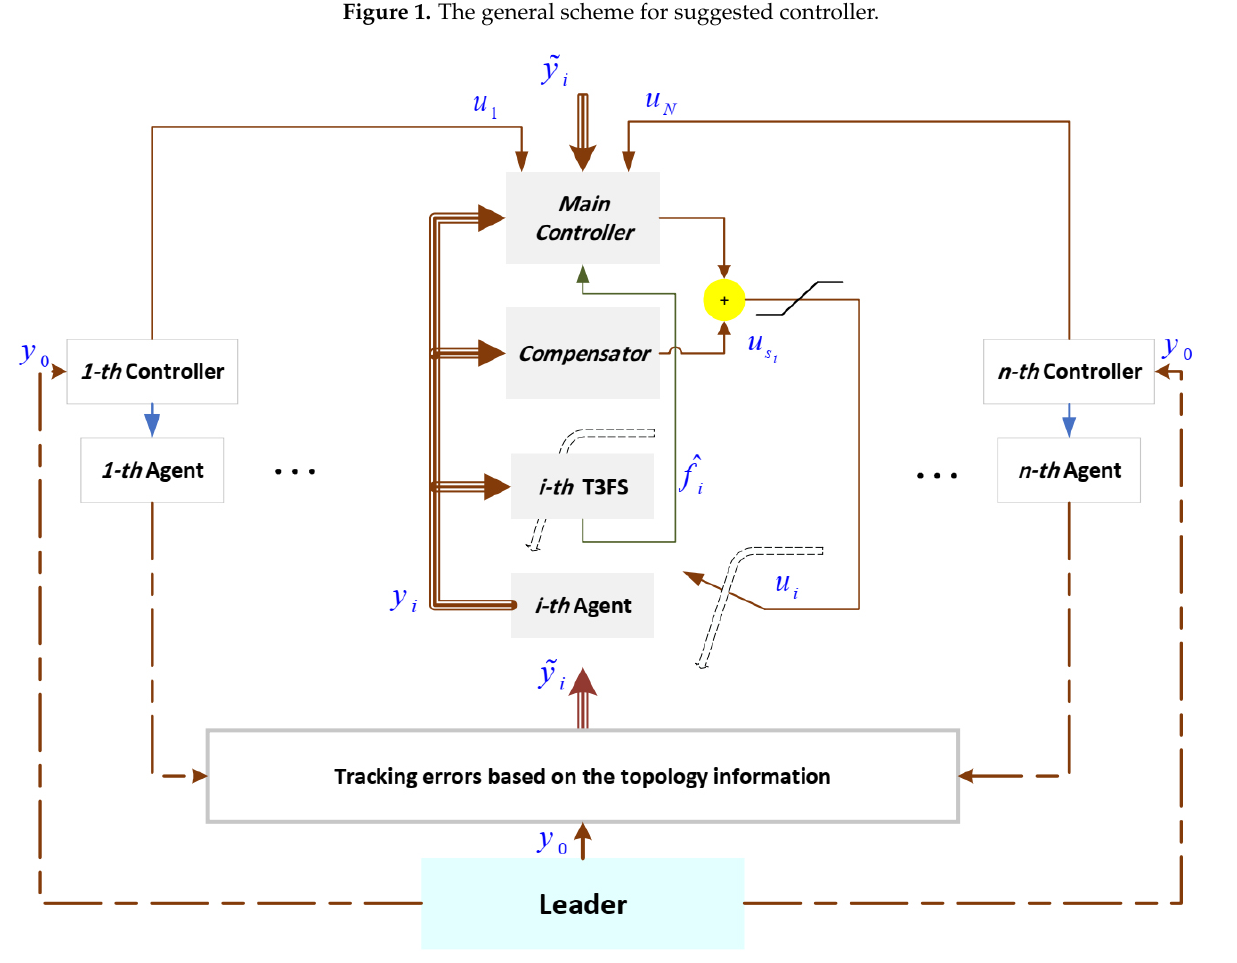
Figure 2. The control block